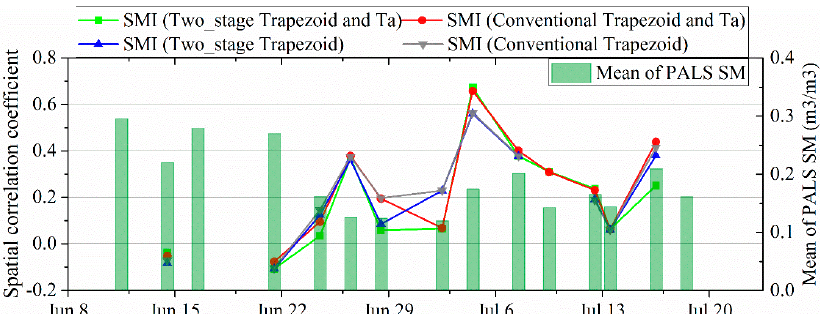
Figure 9. Spatial correlation between LST-derived SMIs and PALS SM. The SMI (two-stage Trapezoid) and (Conventional Trapezoid) are two SMIs based on the two-stage trapezoid and conventional trapezoid with endmembers determining by Sun’s method. The SMI (two-stage Trapezoid and Ta) and (Conventional Trapezoid and Ta) are the other two SMIs based on the two-stage trapezoid and conventional trapezoid with endmembers determining by Long’s method. Sensors 2019 , 19 FOR PEER REVIEW